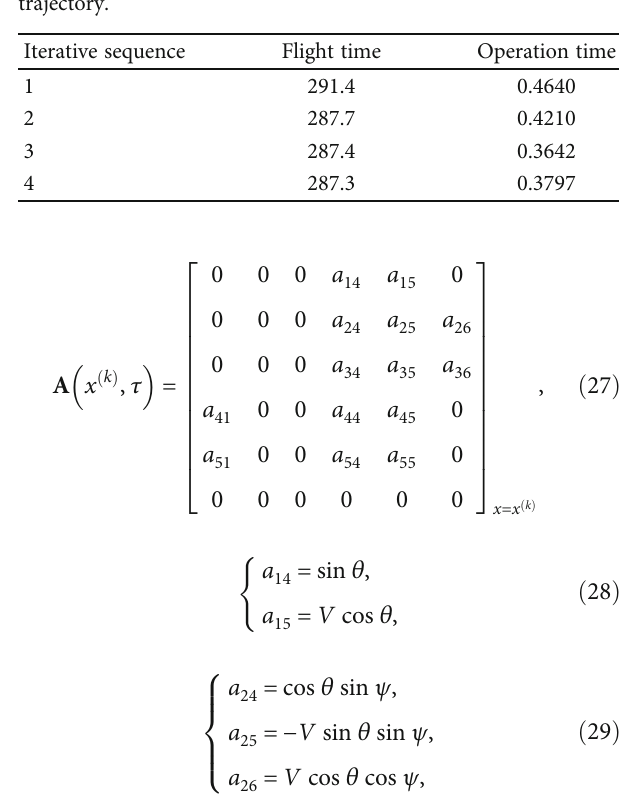
Figure 6: Control variables for convergent Table 4: The fl ight time and operation time of each iteration trajectory.